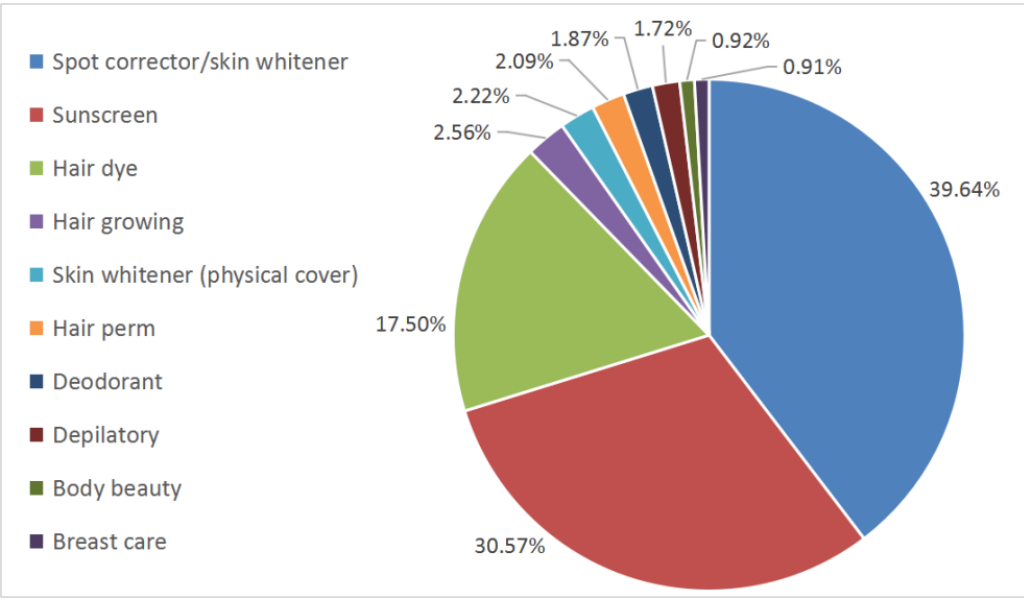
Figure 1. General distribution of existing special cosmetics in China. It is an approximate proportion generated from the total numbers of valid products in each category.